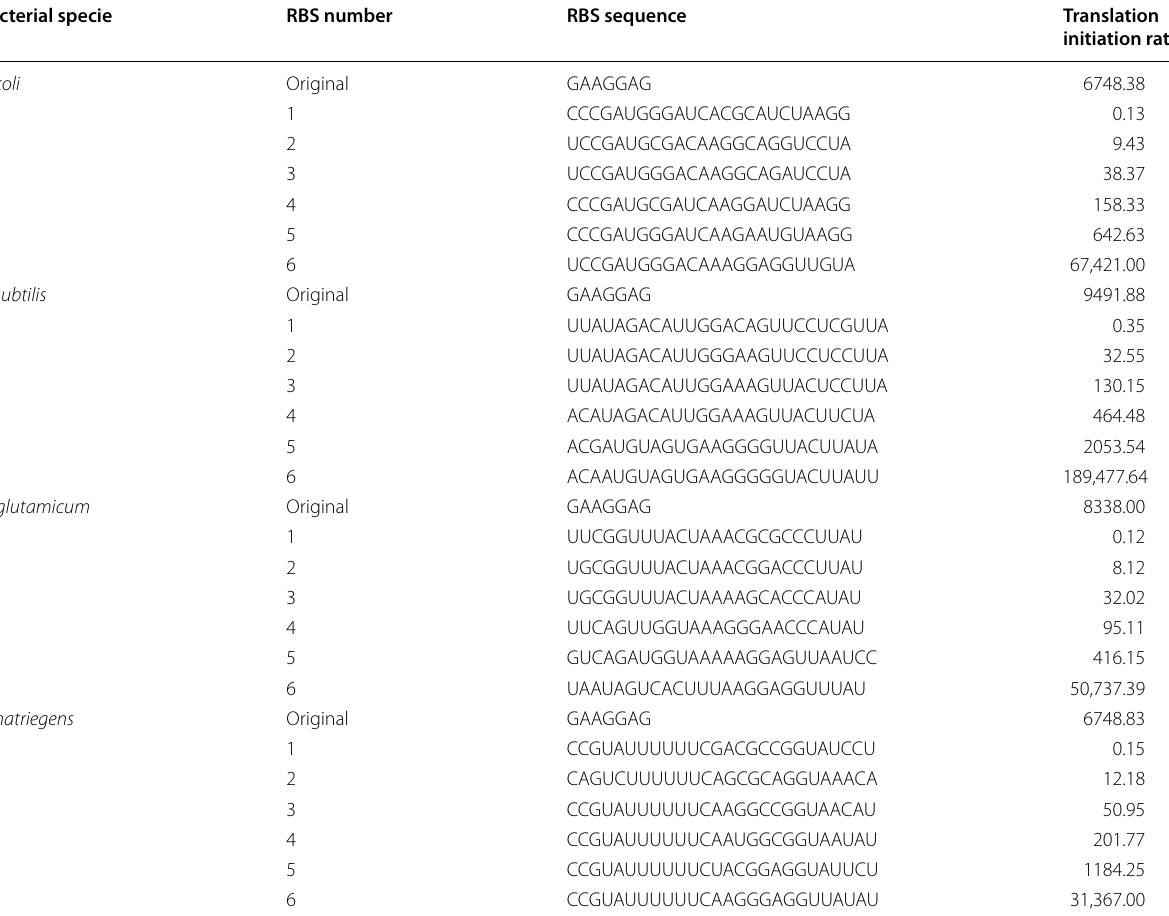
Table 1 RBS sequences designed by RBS Library Calculator Bacterial specie RBS number RBS sequence E.